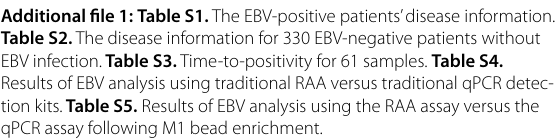
EBV infection. Table S3. Time‑to‑positivity for 61 samples. Table S4. Results of EBV analysis using traditional RAA versus traditional qPCR detec‑ tion kits. Table S5. Results of EBV analysis using the RAA assay versus the qPCR assay following M1 bead